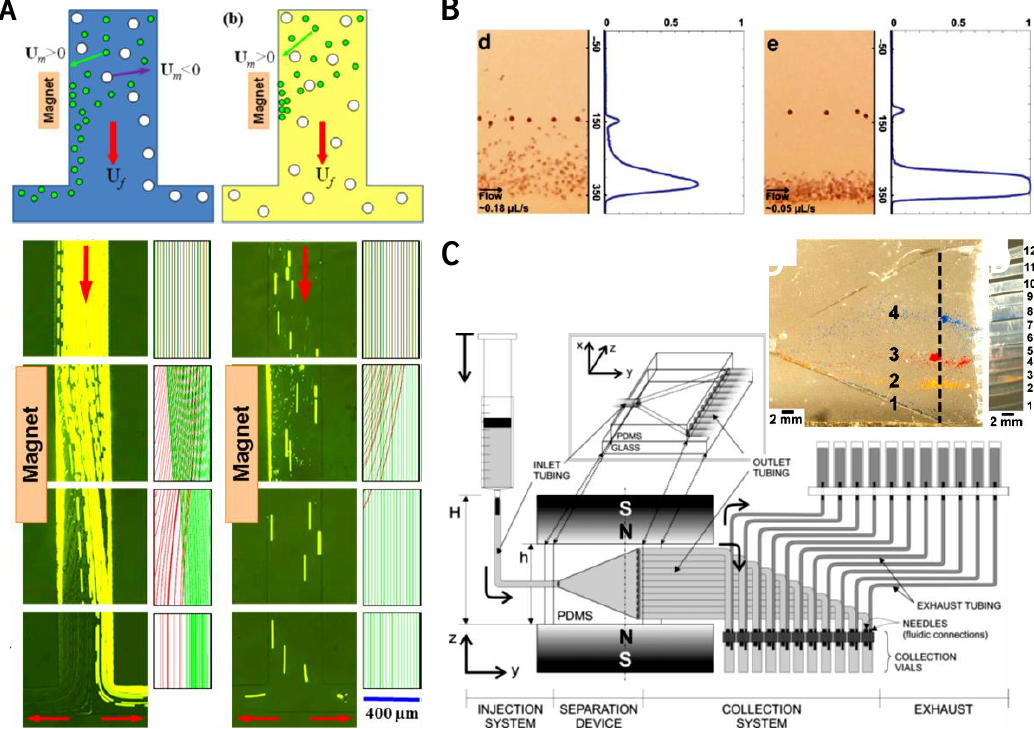
Figure 13. Sheath-free diamagnetic particle separation by non-size properties in the flow of magnetic fluids. ( A ) Schematics comparing the separation of magnetic and diamagnetic particles in ferrofluid (top left) and water (top right); Experimental and theoretical demonstrations of the separation of 2.85 µ m magnetic beads and 10 µ m PS beads in 0.1 × EMG 408 ferrofluid at 240 µ L / h (bottom left) and water at 150 µ l / h (bottom right). Adapted with permission from Liang et al. [144], © 2013 American Institute of Physics. ( B ) Smartphone images showing the density-based separation of PS beads and blood cells in 50 mM Gadavist solution at the flow rates of 0.18 (left) and 0.05 (right) µ L / s. Adapted with permission from Amin et al. [92], © 2016 The Royal Society of Chemistry. ( C ) Schematic representation of the particle separation and collection system (lower) and image of the flow separation of four di ff erent Merrifield resins with di ff erent amounts of chloromethyl functionality in 250 mM GdCl 3 solution (upper). Adapted with permission from Winkleman et al. [146], © 2007 American Chemical Society.